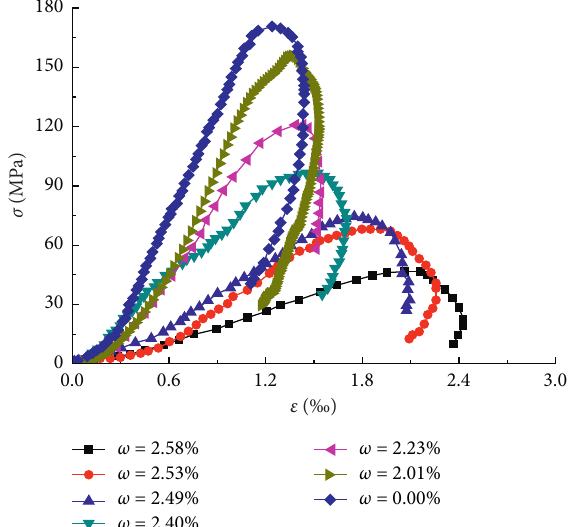
Figure 7: Stress-strain curves of sandstone with different moisture contents under dynamic